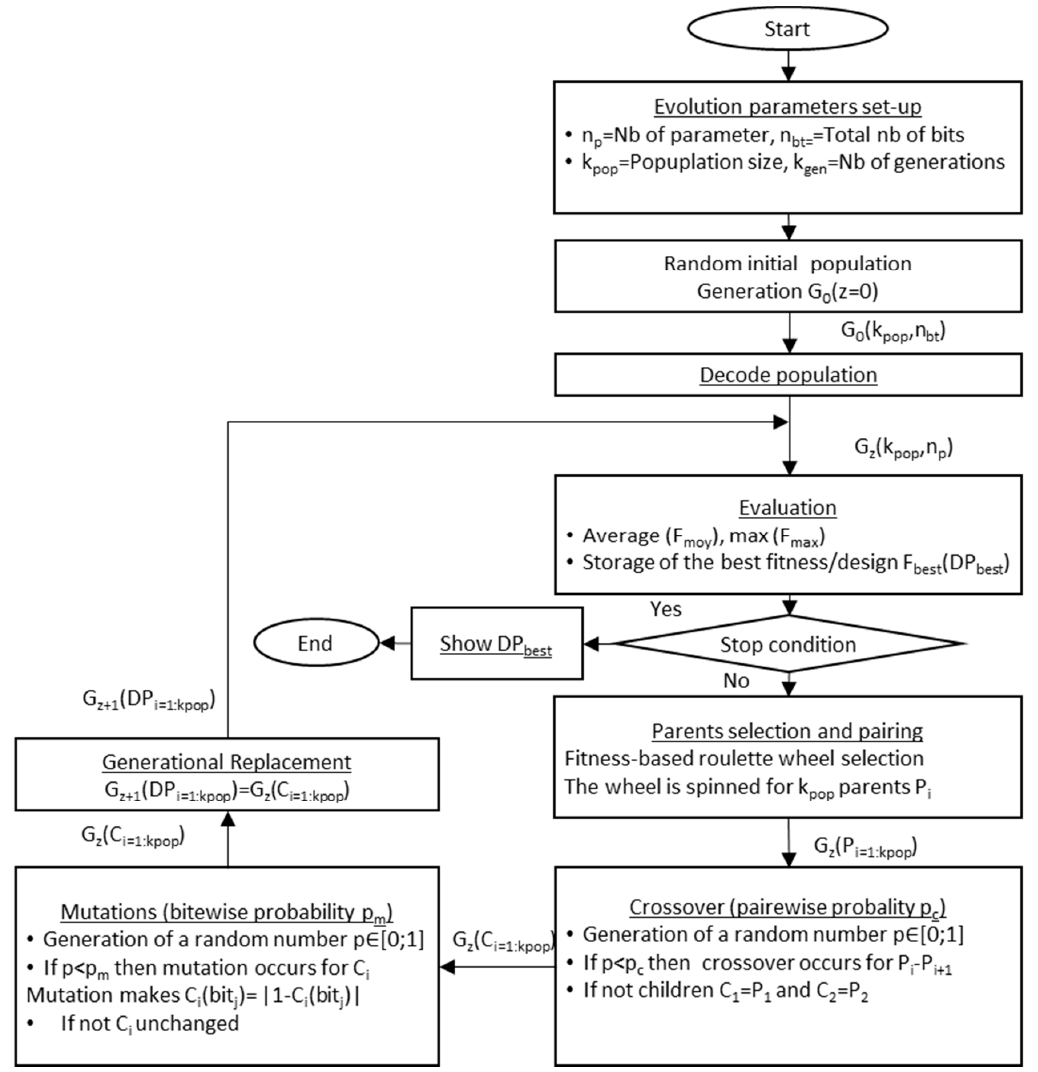
Figure 9. Flowchart of the genetic algorithm.